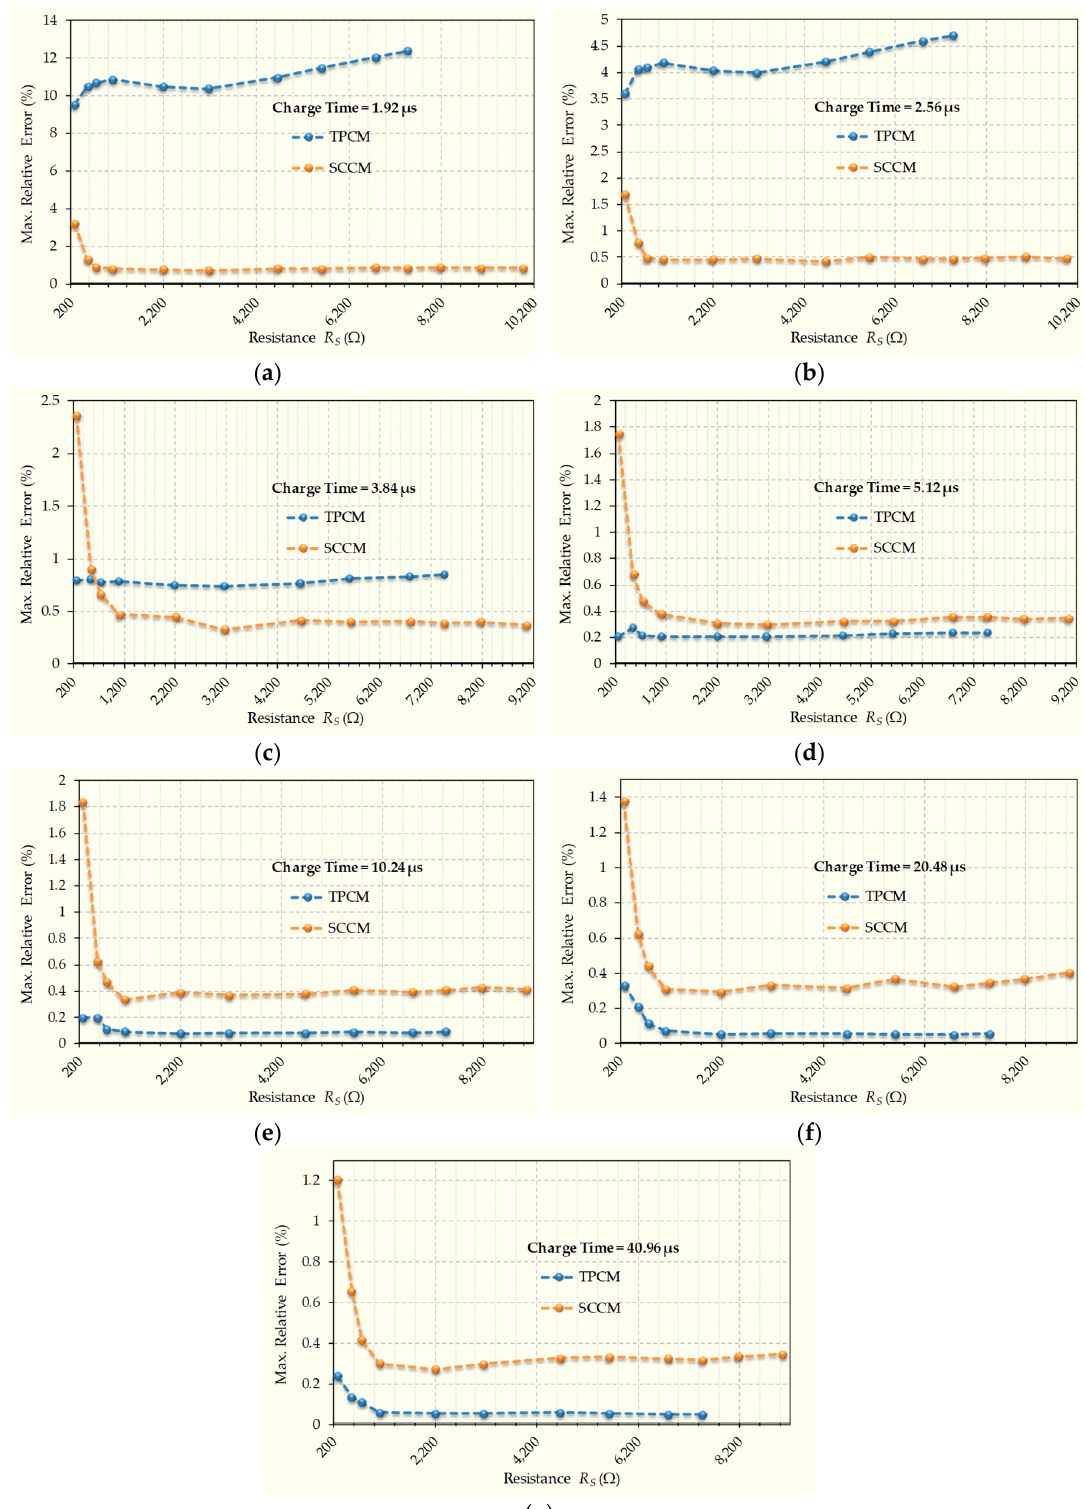
Figure 5. Comparison of maximum relative errors in estimating R S when using the Short-Time Charging Calibration Method (SCCM) or TPCM. Each graph represents a different capacitor charge time. ( a ) charge time of 1.92 µs( b ) charge time of 2.56 µs, ( c ) charge time of 3.84 µs, ( d ) charge time of 5.12 µs, ( e ) charge time of 10.24 µs, ( f ) charge time of 20.48 µs, ( g ) charge time of 40.96 µs.